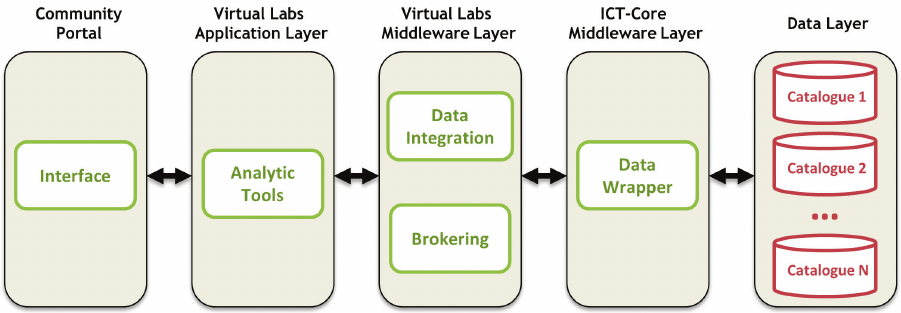
Figure 2. General structure of the service in correspondence with the LifeWatch infrastructure